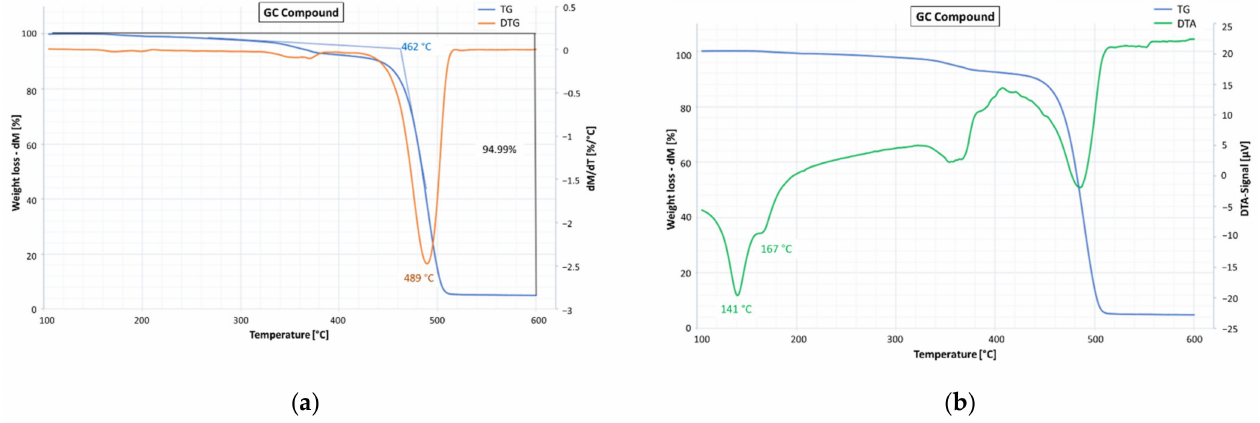
Figure 5. GC compound: ( a ) percentage mass loss TG (blue line) and first derivative of mass loss DTG (red line); ( b ) TG (blue line) and differential thermal profile DTA (green